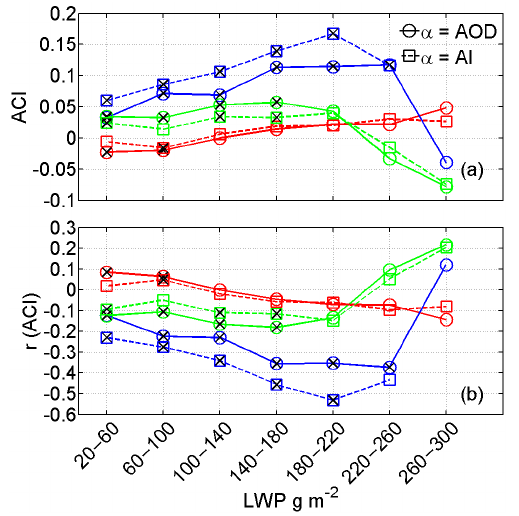
Figure 8. ACI estimates computed for the CER as a function of the LWP and by applying both the AI and AOD as proxies for the CCN are shown in (a) . The correlation coefficients are presented in (b) . The colour-coded lines refer to the three subregions deter- mined in Fig. 1: Area 1 (blue), Area 2 (green) and Area 3 (red). The line styles define whether the AOD or AI were used as the CCN proxy, α . Markers signed with a cross represent points fulfilling the null hypothesis ( p value<0.05), which are hence statistically sig- nificant.